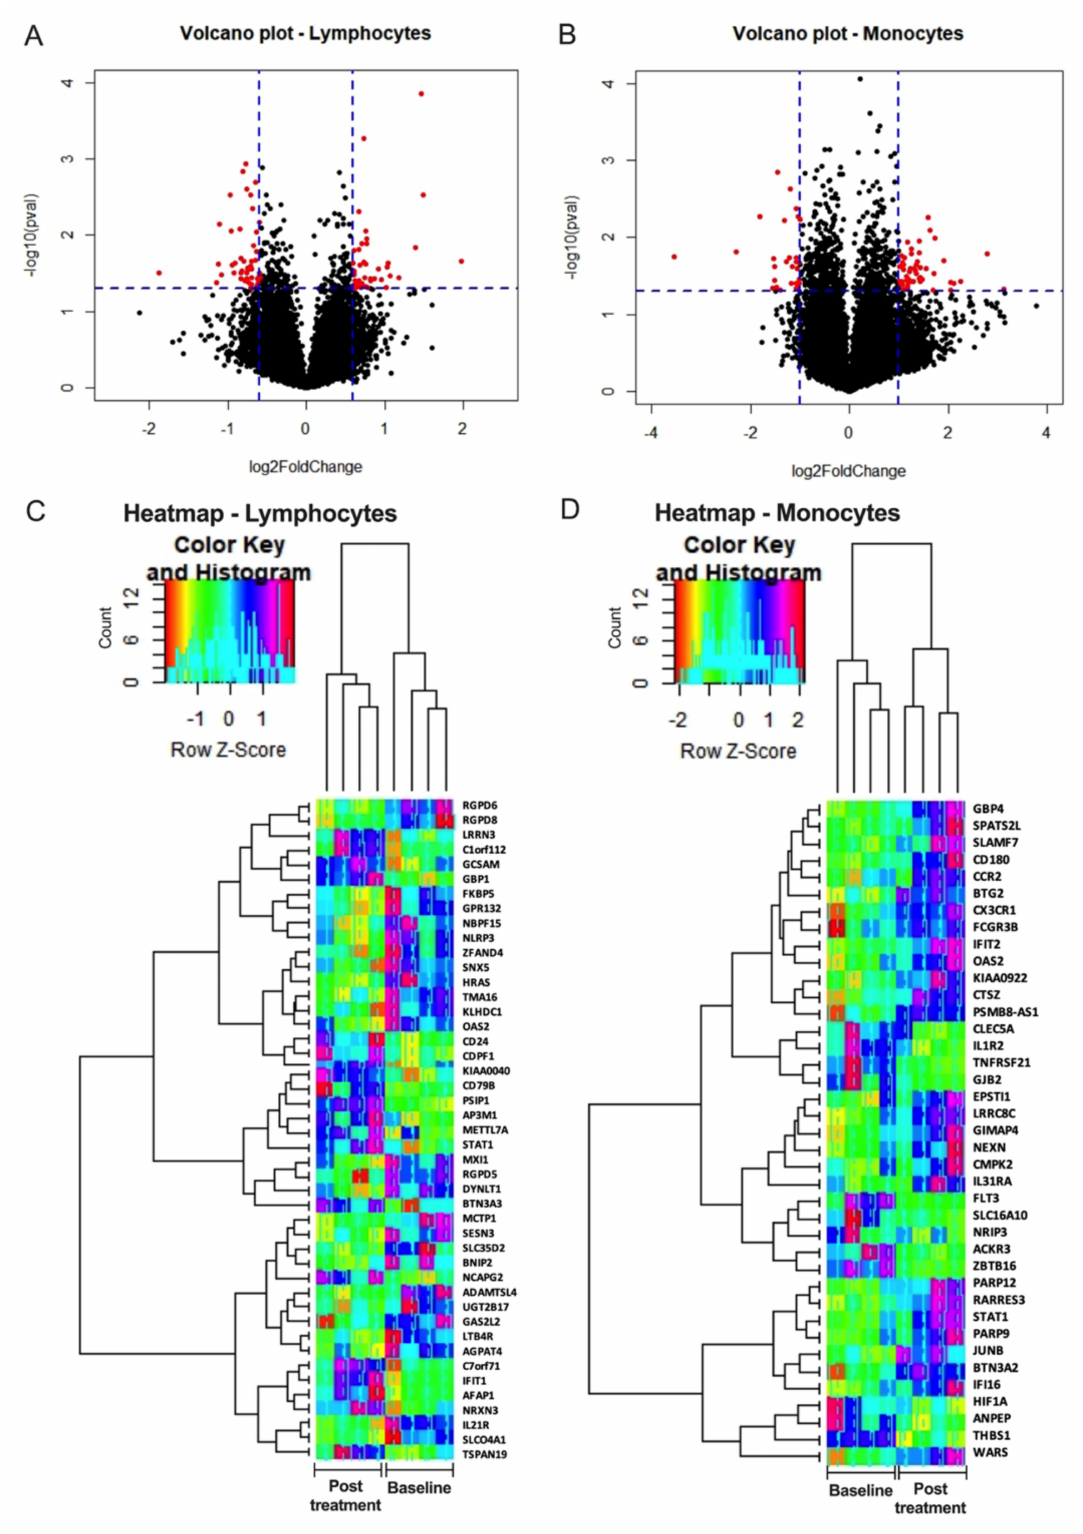
Figure 6. Differential gene expression analyses in lymphocytes and monocytes after oral-SLGN treatment in healthy subjects. Sorted monocytes and lymphocytes from BL and 8 h post-SLGN (3.0 mg) treatment were used for microarray analysis ( n = 4). Volcano Plots show the transcriptomics analyses of differentially expressed mRNAs from ( A ) lymphocytes and ( B ) monocytes post-SLGN treatment versus pre-treatment (baseline) samples. Heatmap analysis of top 50% deregulated genes and dendrogram generated by cluster analysis in ( C ) lymphocytes and ( D ) monocytes are